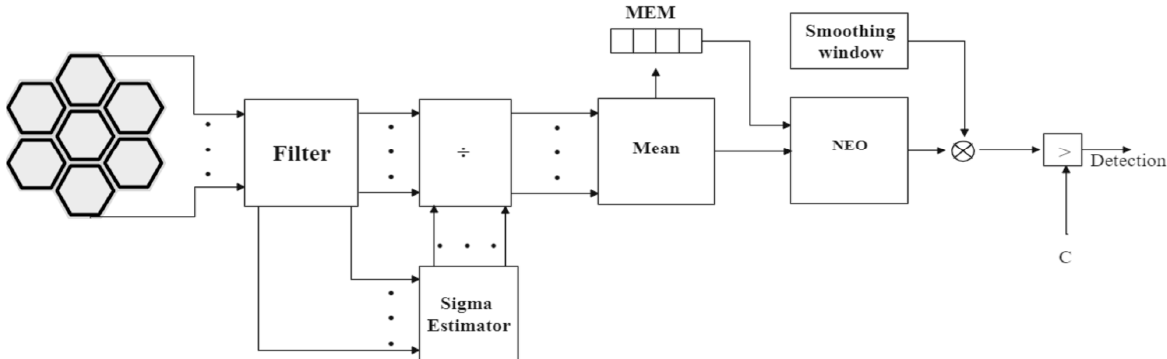
Figure 8. Block diagram of the pre-norm technique. Each channel is normalized with its noise standard deviation estimate and then averaged and processed by SNEO. The comparison with the threshold C gives the detection result.